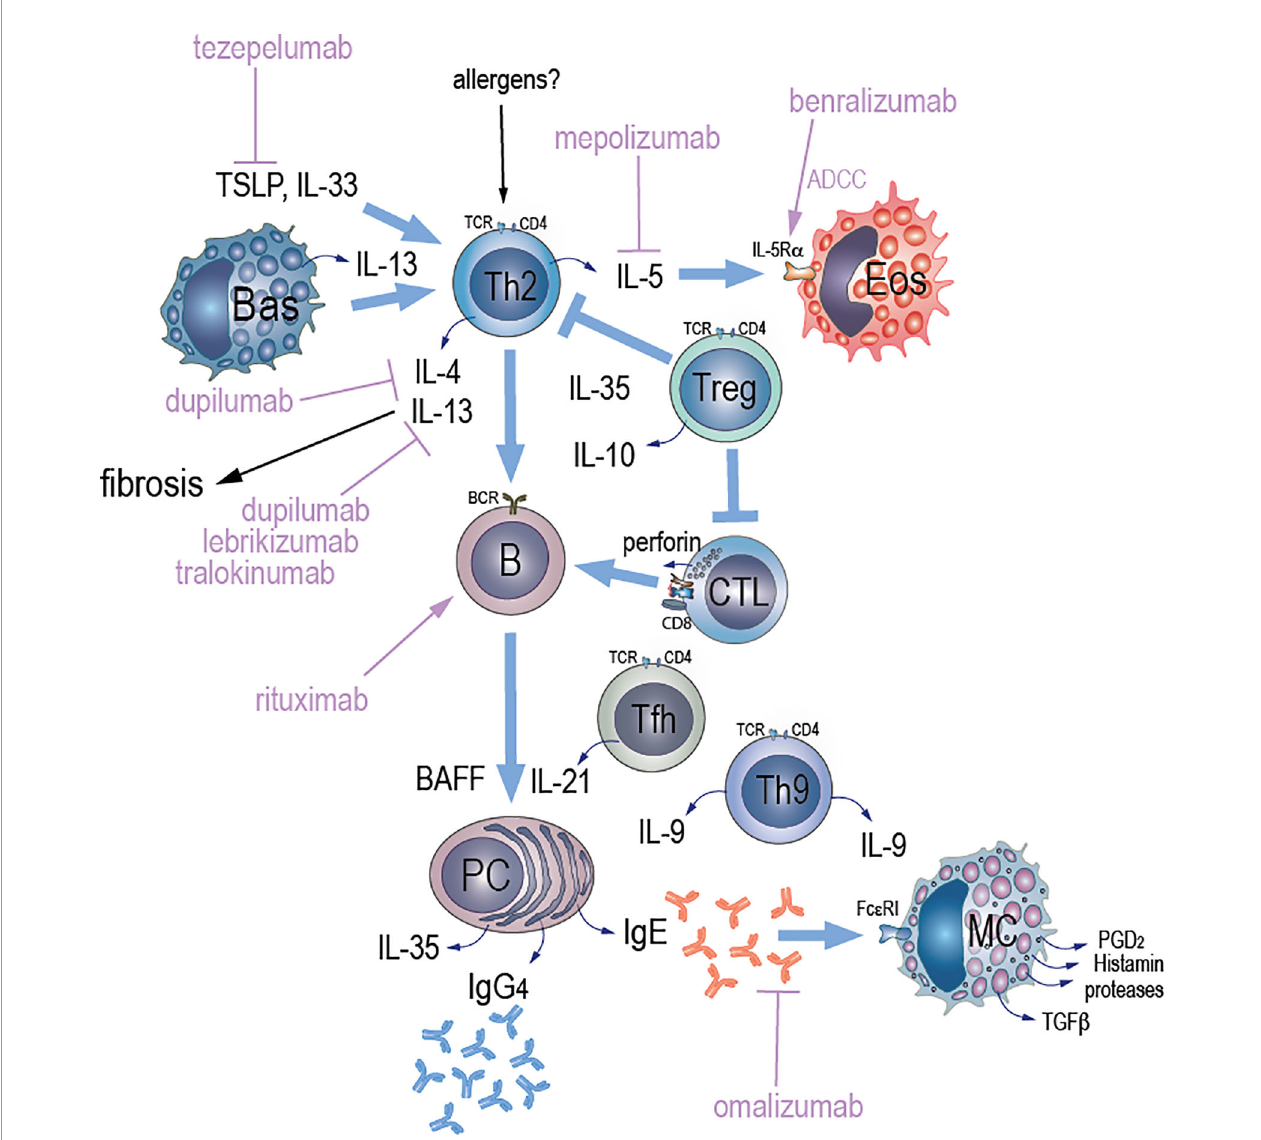
FIGURE 1 | Potential mechanisms of Type 2 immunity and therapeutic targets in IgG4-RD. We hypothesize that an unknown antigenic stimulus (allergen) triggers Th2 cells and activates them to secrete interleukins. Activation of Th2 cells by TSLP promotes secretion of IL-4, IL-5, and IL-13, which activate B cells and eosinophils. Both TSLP and IL-33 may contribute to IgG4 accumulation via induction of a Th2 cytokine environment. TLR-activated basophils secrete BAFF and IL- 13. BAFF that is also secreted from B cells promotes immunoglobulin class switching while IL-13 maintains Th2 cell-dominant immune responses contributing to increased IgG4 production. A population of effector memory CD4+ T cells with a cytotoxic function (CD4+ CTLs) that arises from chronic antigenic stimulation has also been described in IgG4-RD. An antigen-driven process that requires an interaction between CD4+ CTLs and activated B cells that serve as antigen presenting cells might be implicated in the pathogenesis of igG4-RD based on observations of signi fi cant reduction of circulating CD4+CTLs and plasmablasts after glucorticoid therapy or B cell depletion with rituximab through antibody-dependent cell-mediated cytotoxicity (ADCC). Other key players in the pathogenesis of IgG4-RD include follicular CD+T helper (Tfh) cells that induce IgG4 class-switching, expansion of plasmablasts, and production of autoantibodies. Tfh cells drive immunoglobulin class switching and promote ectopic GC formation through IL-21 production. IL-10 that is secreted by T regulatory (Treg) cells drives the differentiation of IgG4-class- switching B cells to IgG4-secreting plasma cells, whereas IL-35 may suppress in fl ammation via activation of effector Tregs and suppression of CD4+CTLs. Plasma cell derived IL-35 may also drive the differentiation of naïve CD4 T cells towards a Th9 phenotype, and IL-9 release, which further promotes plasma cell differentiation and IgG4 immunoglobulin class switching. IgE secreted by plasma cells stimulates mast cells via its binding to the high-af fi nity IgE receptor (Fc e RI) leading to release of granule contents and cytokines, which together drive collagen production and fi brosis. Targeting of TSLP-mediated signaling pathway with tezepelumab, and resultant abrogation of Th2 cascades, might be one of potential therapeutic options in IgG4-RD. Blocking both IL-4 and IL-13 signaling pathways with dupilumab might reduce in fl ammation and fi brosis in igG4-RD. Blockage of IL-13 signaling pathway that is implicated in Th2-related fi brosis with either lebrikizumab or tralokinumab might be another attractive therapeutic target in igG4-RD. Depletion of IL-5R-expressing eosinophils through ADCC with benralizumab or blockage of IL-5 with mepolizumab might reduce eosinophilia and could be an alternative therapeutic targets in patients with IgG4-RD that have peripheral or tissue eosinophilia. Dissociation of pre-bound IgE from Fc e RI with omalizumab might reduce activation of mast cells and production of TGF- b 1 that induces fi